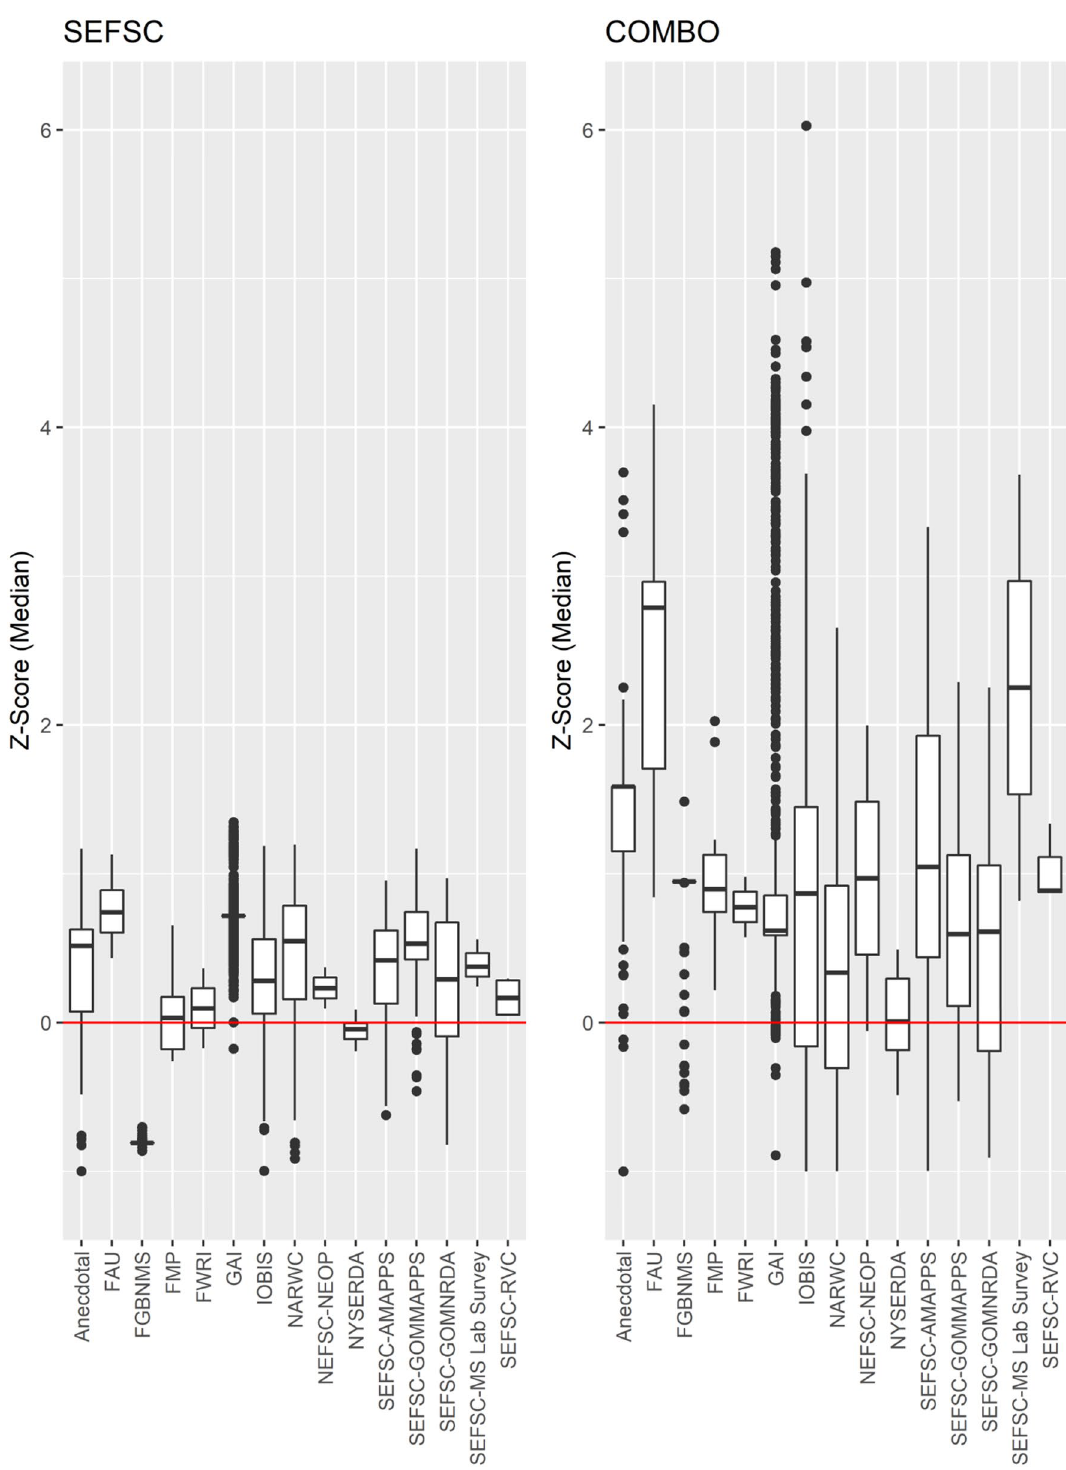
Figure 7. External validation of predictive utility of SEFSC and combined (“COMBO”: SEFSC, NARWC, and NYSERDA) surveys species distribution models, showing predicted median Z-score standardized probabilities for independent observations for manta rays (see Table 1). Positive Z-scores (above red line) indicate consistency between independent observations and model predictions, with higher Z-scores indicative of greater predictive